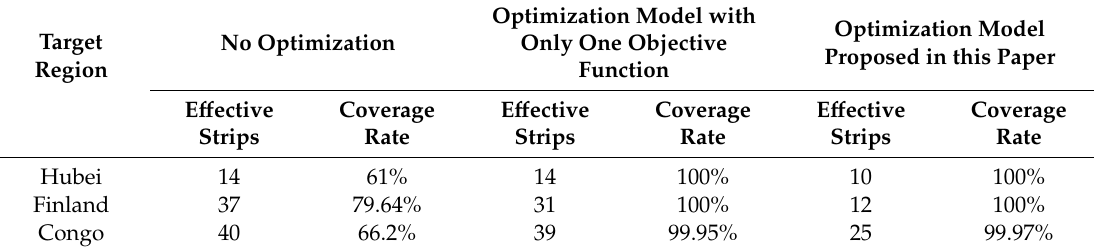
Table 5. Swing angle of each satellite imaging strip in model with only one objective function. Target Swing Angle Region GF1 GF6